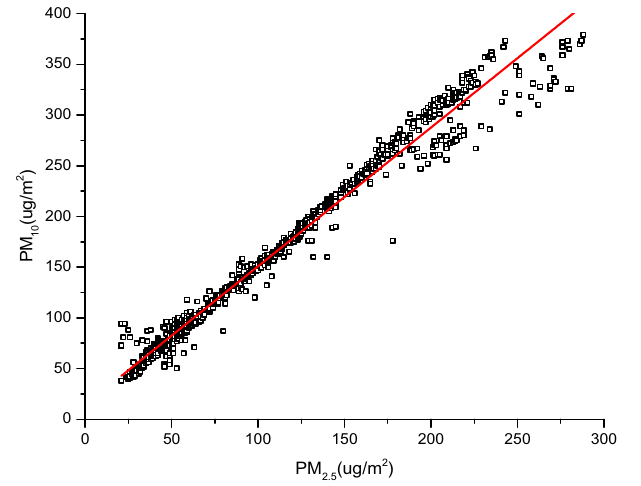
Figure 2. Scatter diagram of relationship between PM 2.5 and PM 10 .